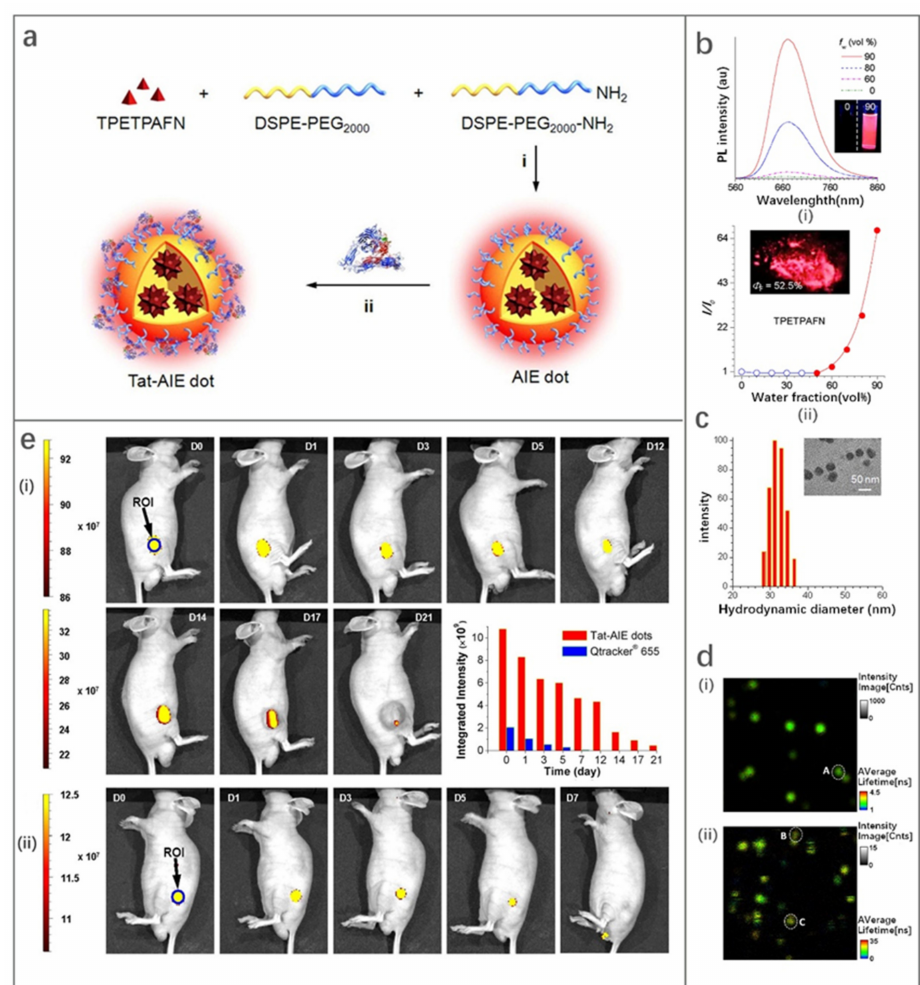
Figure 10. ( a ) Schematic illustration of fabrication of Tat-AIE dots. ( b ) ( i ) Photoluminescence (PL) spectra and ( ii ) I/I 0 intensity of TPETPAFN in THF/water mixtures with different water fractions. ( c ) Particle size distribution and morphology of Tat-AIE dots. ( d ) Fluorescence lifetime imaging (FLIM, 5 × 5 µ m 2 ) results of ( i ) Tat-AIE dots and ( ii ) Qtracker ® 655. ( e ) In vivo fluorescence imaging of tumor cells by Tat-AIE dots. ( i ) Representative in vivo fluorescence images of the mouse subcutaneously injected with 1 × 10 6 of C6 glioma cells after staining by 2 nM Tat-AIE dots. ( ii ) Data for Qtracker ® 655 obtained under similar conditions. The inset in the middle panel showed the integrated PL intensities of the regions of interest (blue circles) at the tumor sites from the corresponding images. Reproduced with permission from Ref. [111], copyright 2022, Springer